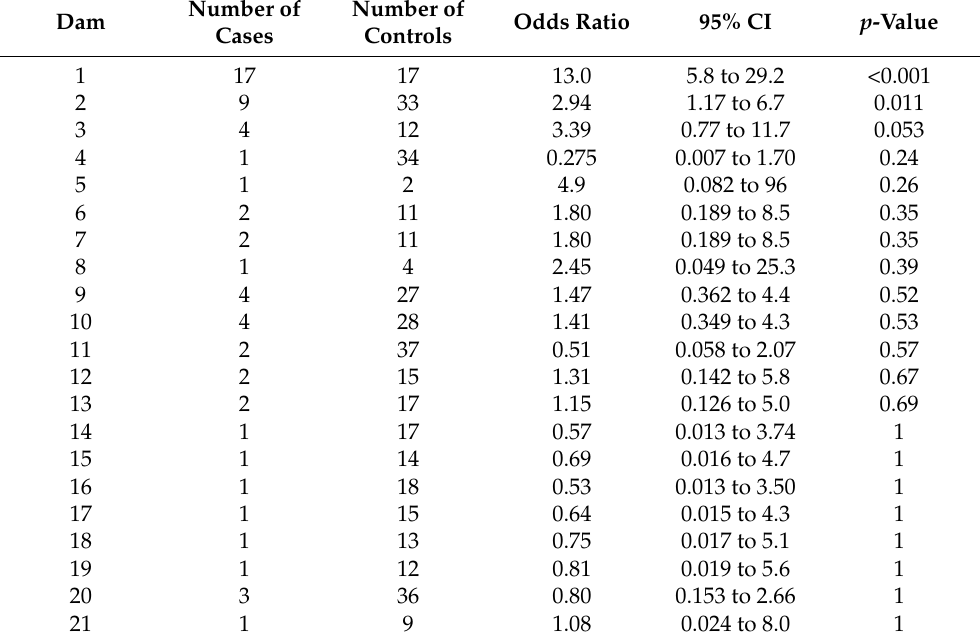
CI = confidence interval. Odds ratios rounded according to Cole [22].